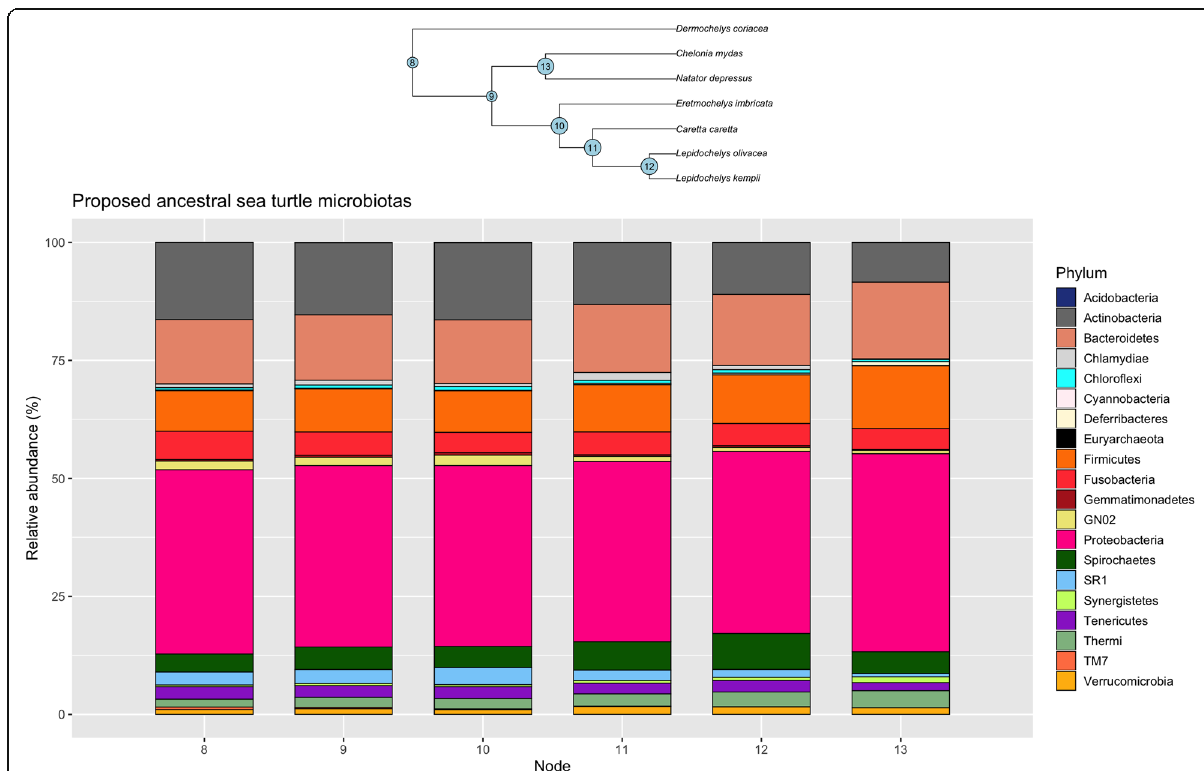
Fig. 4 Proposed microbiotas for extinct sea turtle species with phylogenetic tree. Numbered nodes represent extinct ancestors on the sea turtle phylogenetic